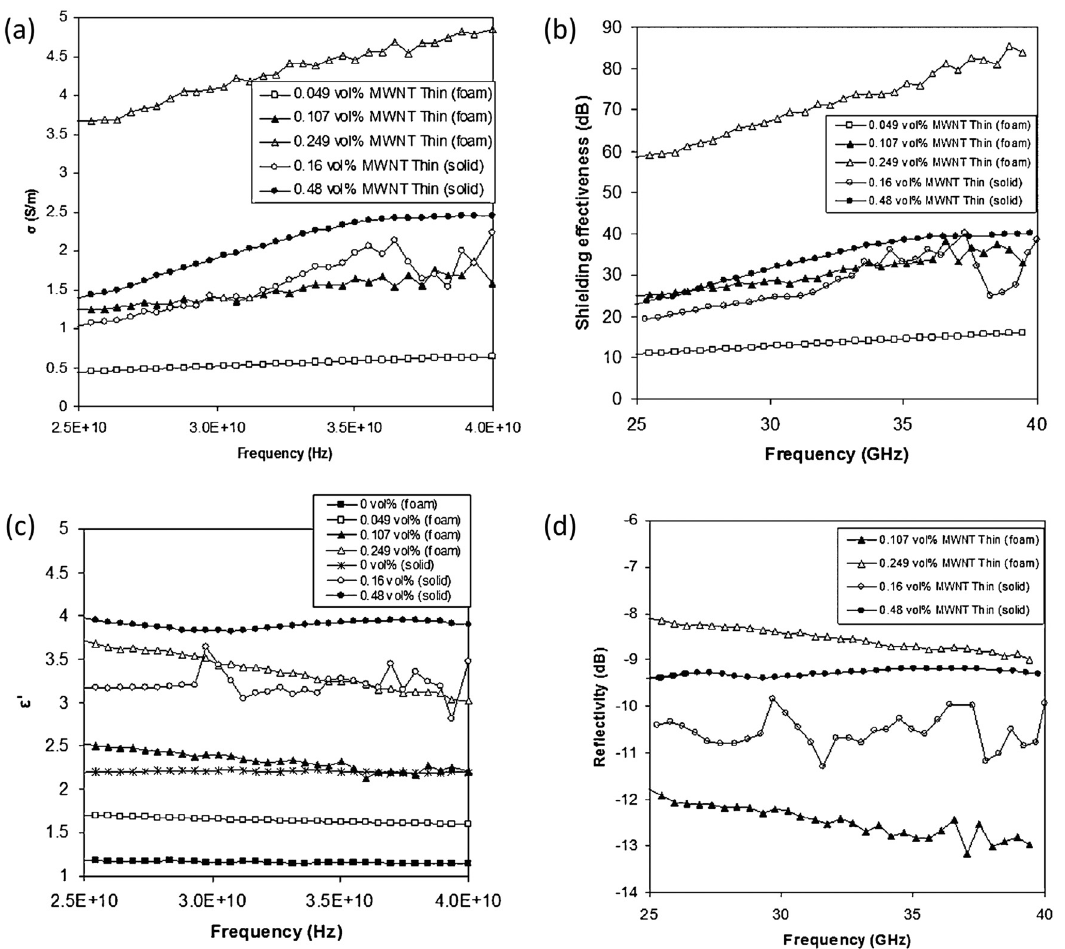
Figure 5: Electromagnetic properties of foamed and unfoamed MWNT/PCL nanocomposites: a ) electrical conductivity, ( b ) SE, ( c ) dielectric constant, ε r and ( d ) re fl ectivity, R [ 75 ]